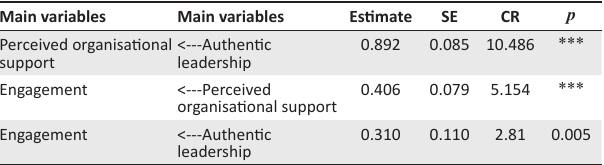
TABLE 5: Regression estimates for the proposed model of research.